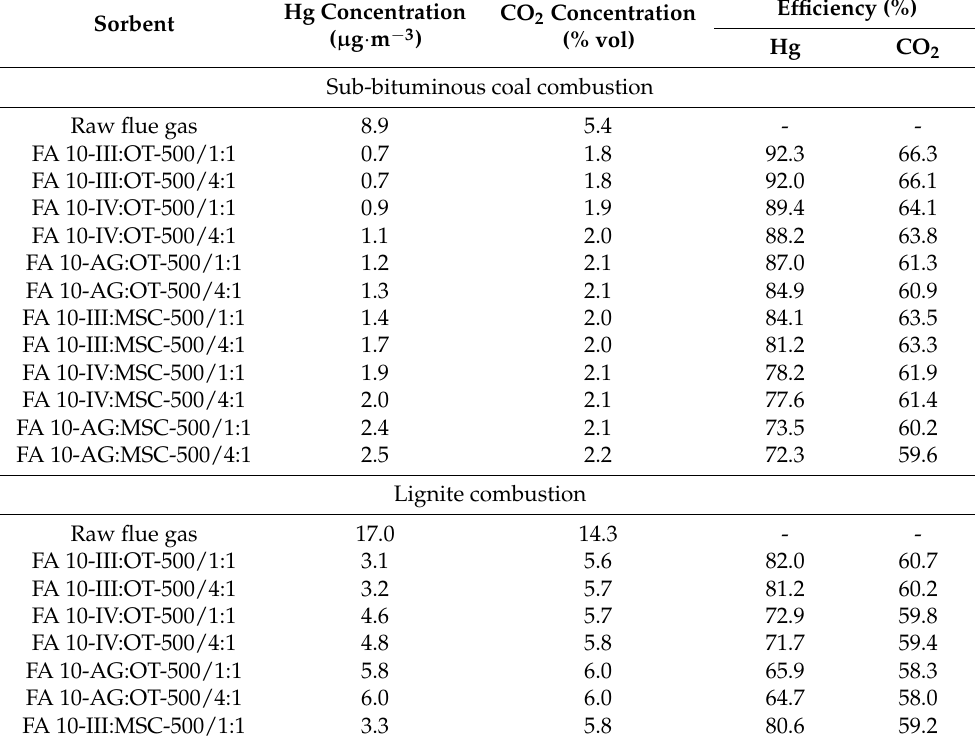
Table A1. Efficacy assessment of MFA for Hg and CO 2